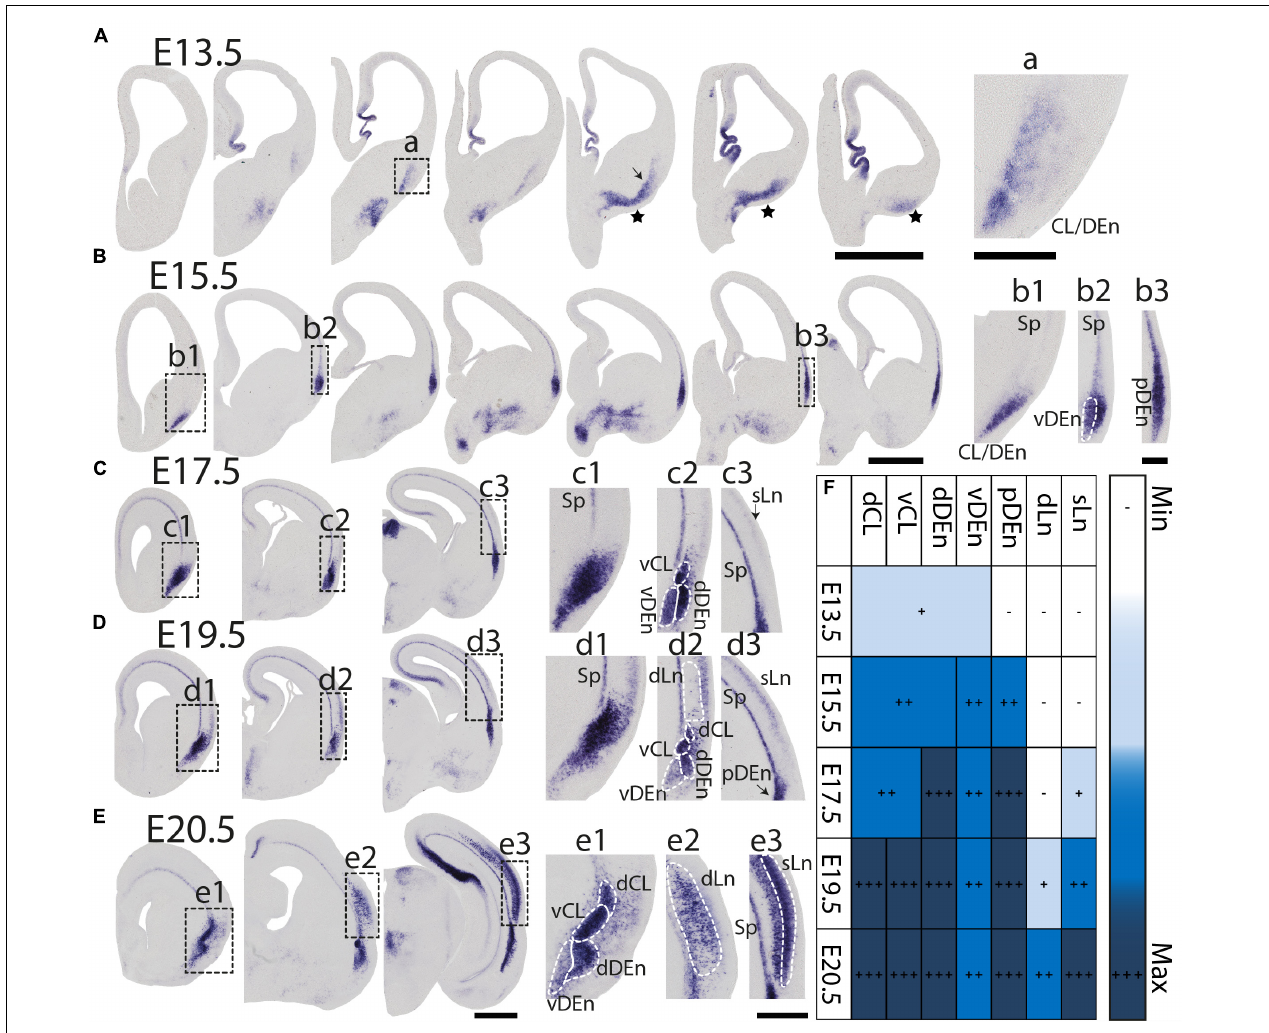
FIGURE 2 | Prenatal development of Nurr1 expression. Nurr1 expression on E13.5 (A) , on E15.5 (B) , on E17.5 (C) , on E19.5 (D) and on E20.5 (E) . High magnification Nurr1 labeled regions from E13.5 to E20.5 (a–e), including the CL/DEn on E13.5, the Sp, vDEn, and pDEn on E15.5, the sLn on E17.5, the dLn, vDEn, dDEn, vCL and dCL on E19.5, and all sub-regions on E20.5. (F) Table of prenatal development of Nurr1 expression. White and “–” indicate no expression, light blue and “ + ” indicate beginning Nurr1 expression, higher expression is shown in darker color and more “ + ” signs. N = 2 rats for each date. Scale bars in panels (A–E) = 1 mm. Scale bars in panels (a–b) = 200 µ m. Scale bars in panels (c–e) = 500 µ